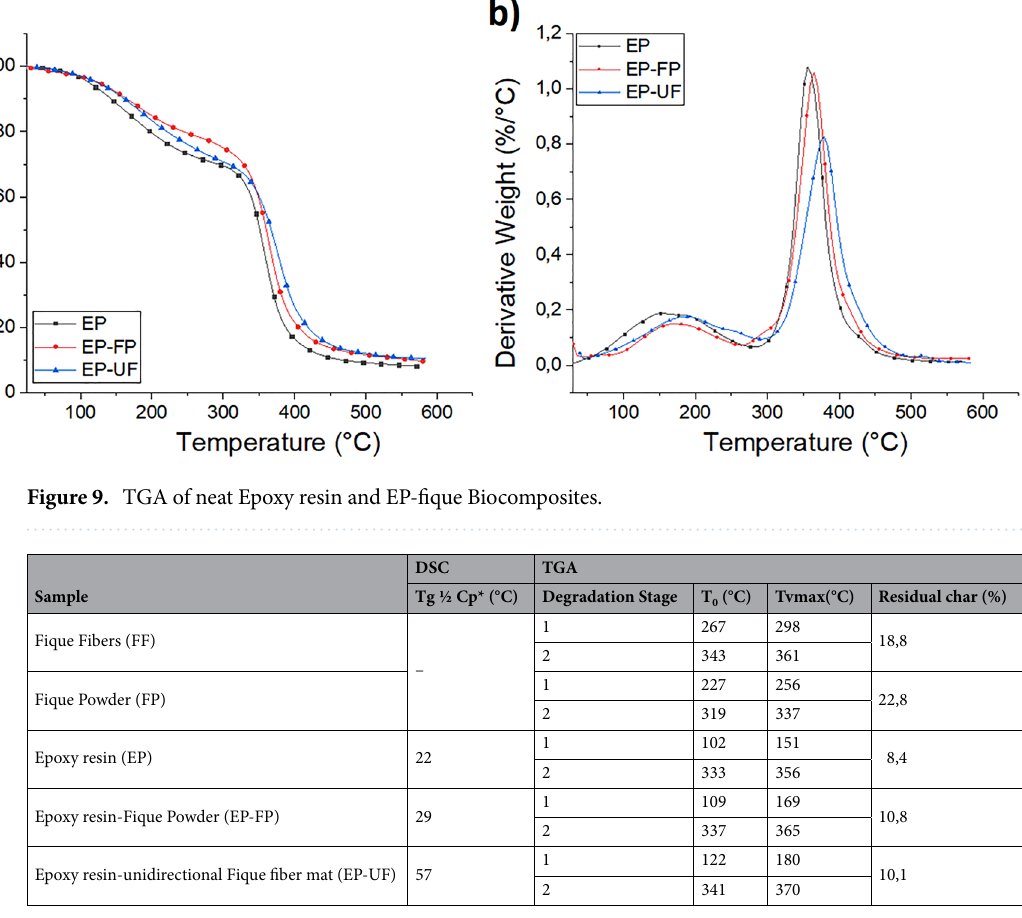
Table 2. Thermal properties of fique, neat EP and their fique biocomposites. *Tg was determinate by the half step temperature.